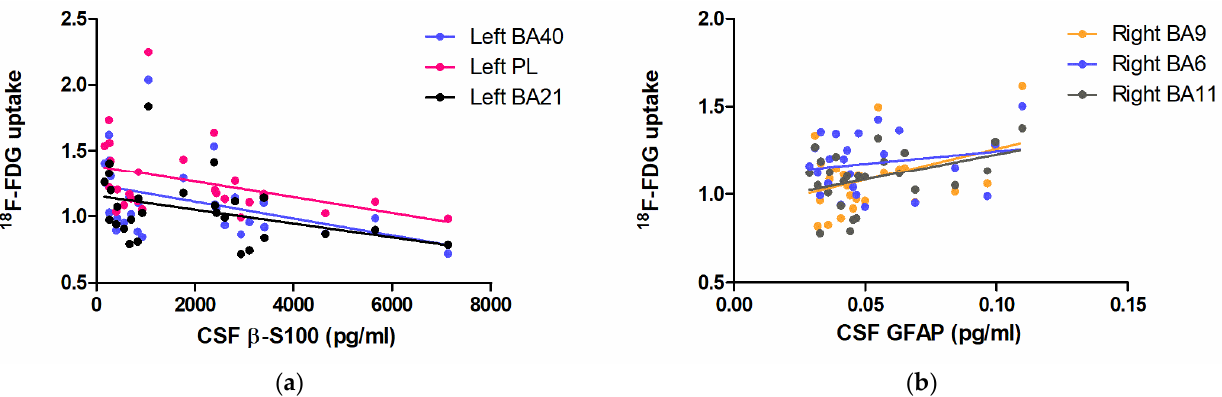
Figure 3. Scatter plots demonstrating the linear relationship between CSF β -S100 and 18 F-FDG brain uptake in the left BA40 (blue), left BA21 (black), and the enlarged hub in the homolateral parietal lobe (PL, pink) ( a ); the relationship between CSF GFAP and 18 F-FDG brain uptake in the right BA9 (orange), BA6 (blue) and BA11 (grey) ( b ).